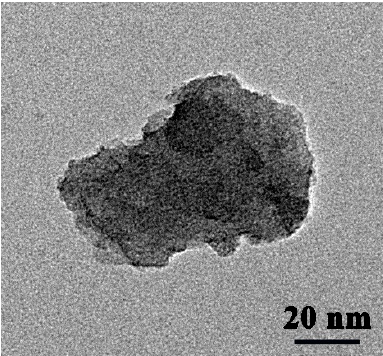
Figure 4. FTIR spectra of TiO 2 –SiO 2 hybrid film T33S67, SiO 2 film and TiO 2 film.